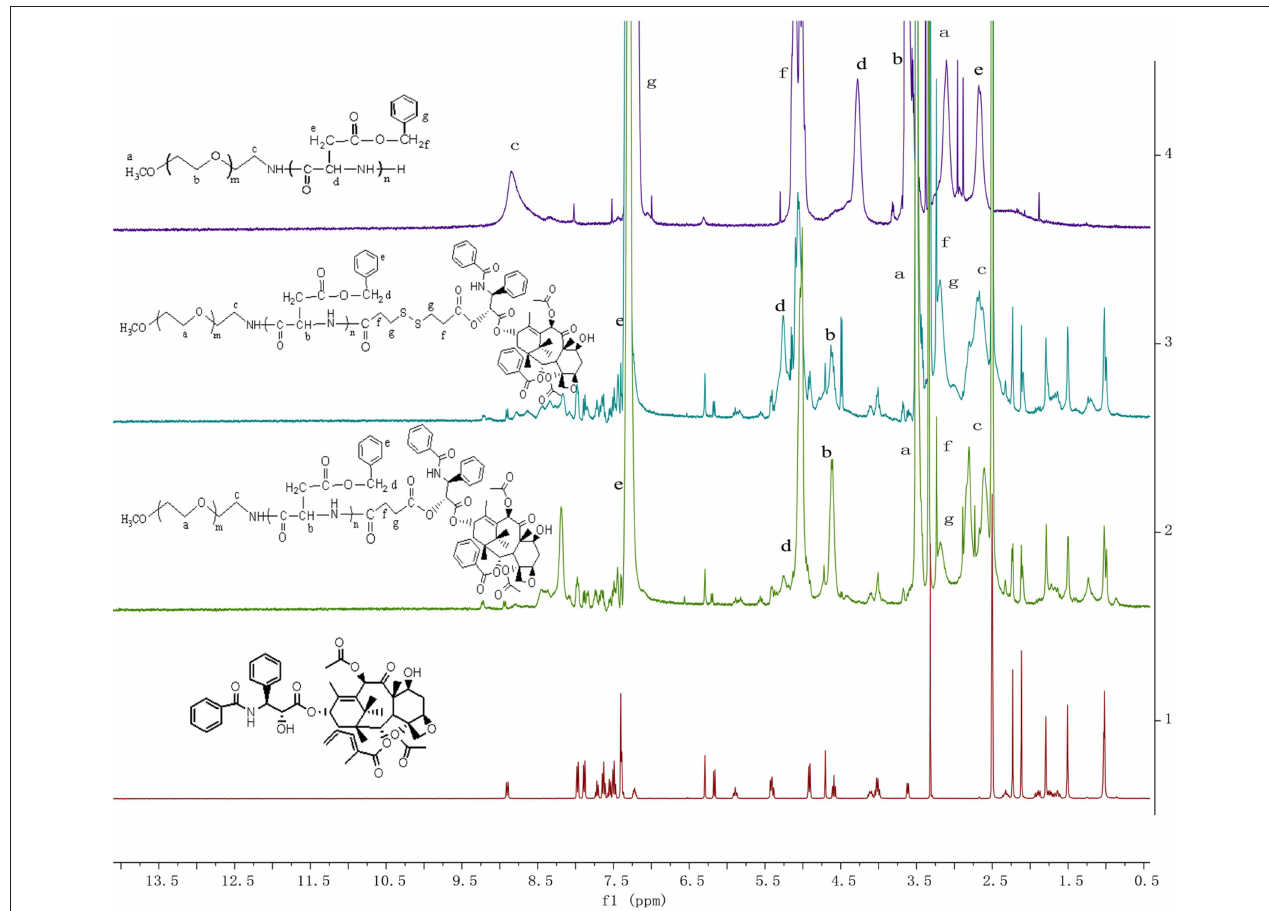
FIGURE 1 | The 1 H NMR spectra of PPCP, PPSP, mPEG-PBLA, and PTX in DMSO-d6.